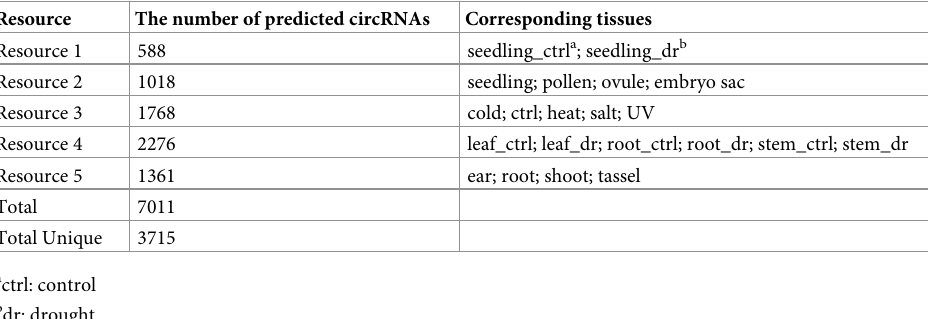
Table 1. The number of predicted circRNAs from five